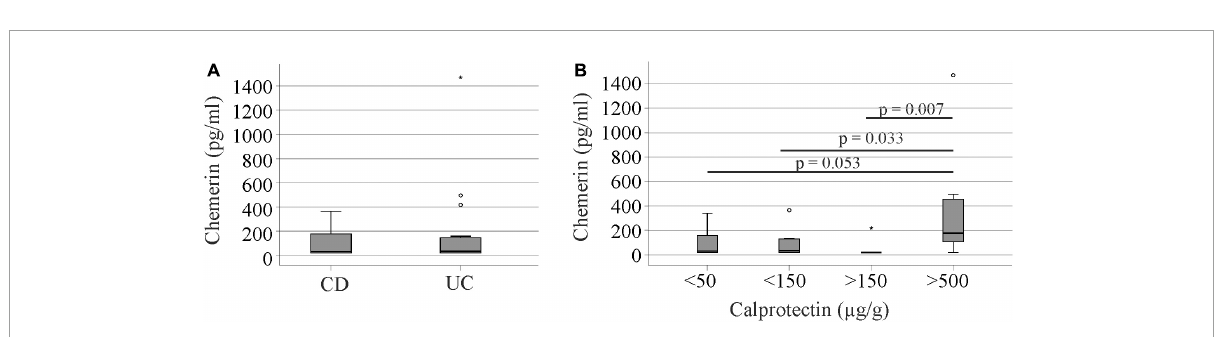
FIGURE5 Urinary chemerin protein in Crohn’s disease (CD) and ulcerative colitis (UC) patients and in relation to fecal calprotectin. (A) Urinary chemerin of CD and UC patients. (B) Urinary chemerin protein stratified for fecal calprotectin levels. Circles (1.5 box lengths from the median) and asterisks (three box lengths from the median) mark outliers.